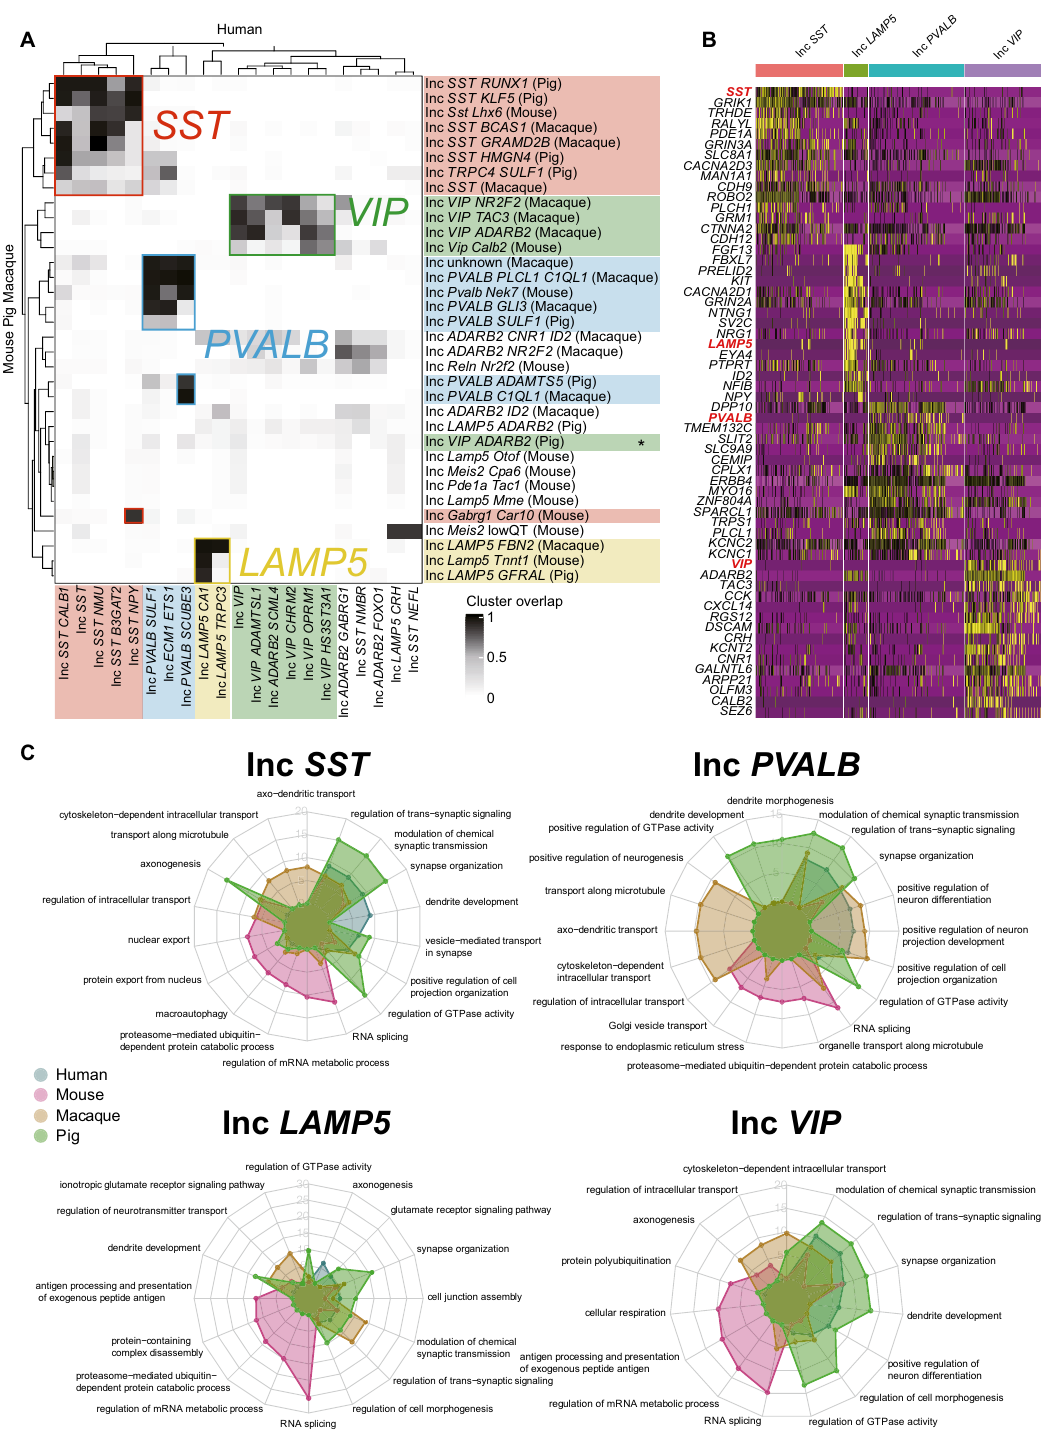
Figure 2. The conserved and diverse GABAergic subclasses across species and their functional features. ( A ) Heatmap showing the cluster overlaps of GABAergic subclasses between human and the other three species. ( B ) Heatmap showing top 15 DEGs of conserved GABAergic neuron types containing Inc SST , Inc LAMP5 , Inc PVALB , and Inc VIP . ( C ) The GO terms are enriched from conserved and specific genes in the four species. Blue: Human; Red: Mouse; Brown: Macaque; Green: